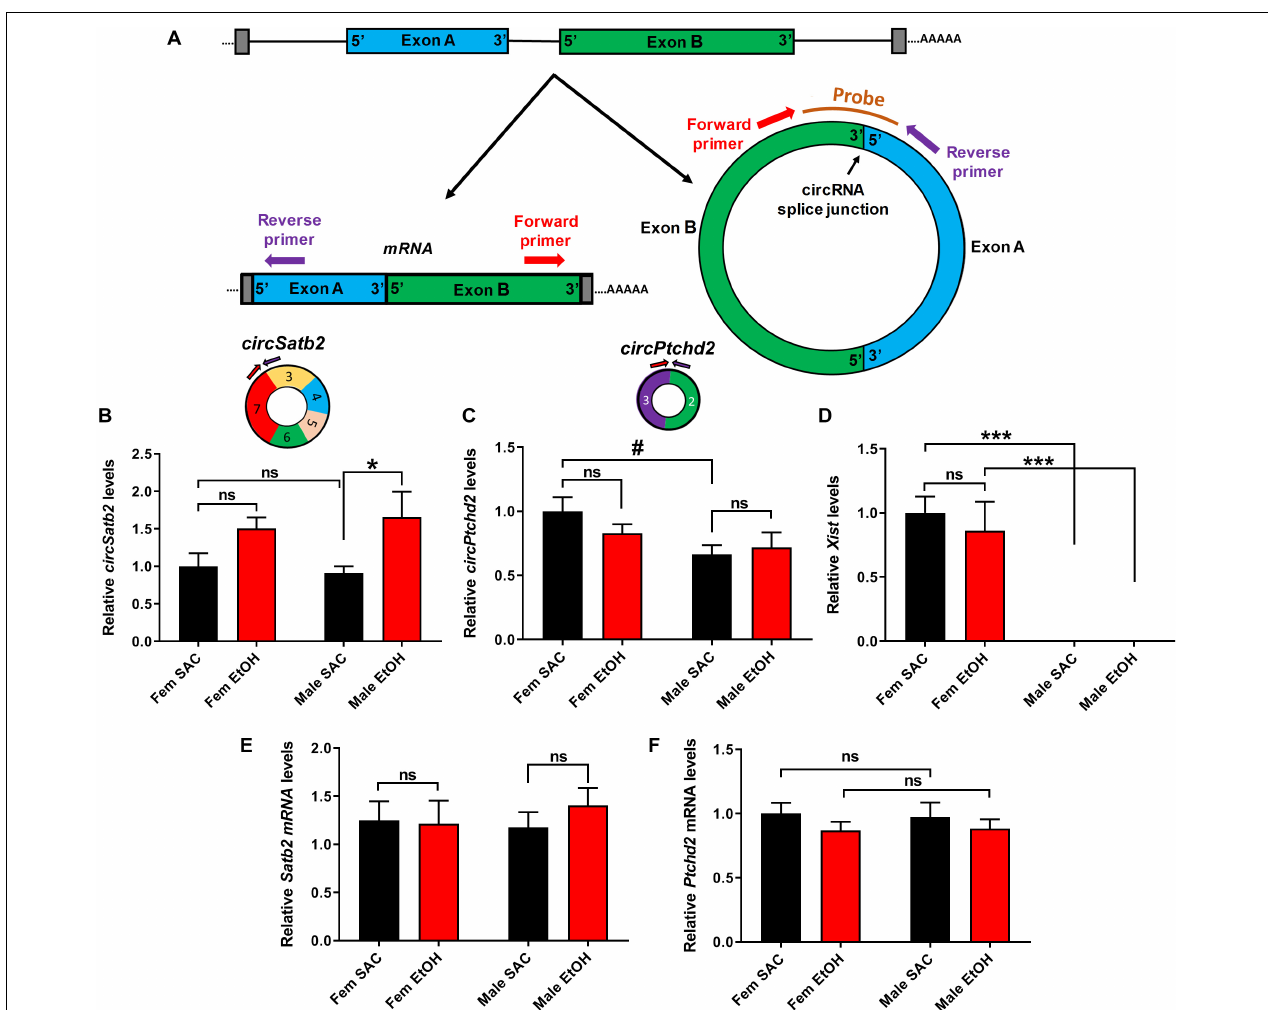
FIGURE 4 | Validation of sex-dimorphic circRNA expression via circRNA-specific qRT-PCR. (A) Schematic representation of a simplified example of circRNA biogenesis resulting from back-splicing events of exon A and Exon B from a hypothetical precursor mRNA. The divergent primers for circRNA qRT-PCR validation were designed such that only the back-spliced and not linear junction were targeted as shown in the figure. (B,C) Bar graph showing mean + SEM relative to FEM SAC Control circSatb2 (B) and circPtchd2 (C) expression. Circles depict the schematic representation of circPtchd2 and circSatb2 formation from their respective exons. (D) Bar graph showing mean ± SEM levels of the female-specific lncRNA Xist expression (positive control). (E,F) No significant difference in linear Satb2 and Ptchd2 mRNA expression. In (B–F) # 0.05 < p < 0.10, * p < 0.05, *** p < 0.001 based on one-way Analysis of Variance (ANOVA) with Sidak’s multiple comparisons correction. In all figures, circRNA and mRNA quantification was done via qRT-PCR (normalized to circTulp4 for circRNAs or 18S rRNA for mRNAs). Bar graphs showing mean ± SEM relative to female SAC (control). Normalized values were divided to the mean of each control group and the relative to control ratios were graphed as means ± SEM. N = 4–6 per